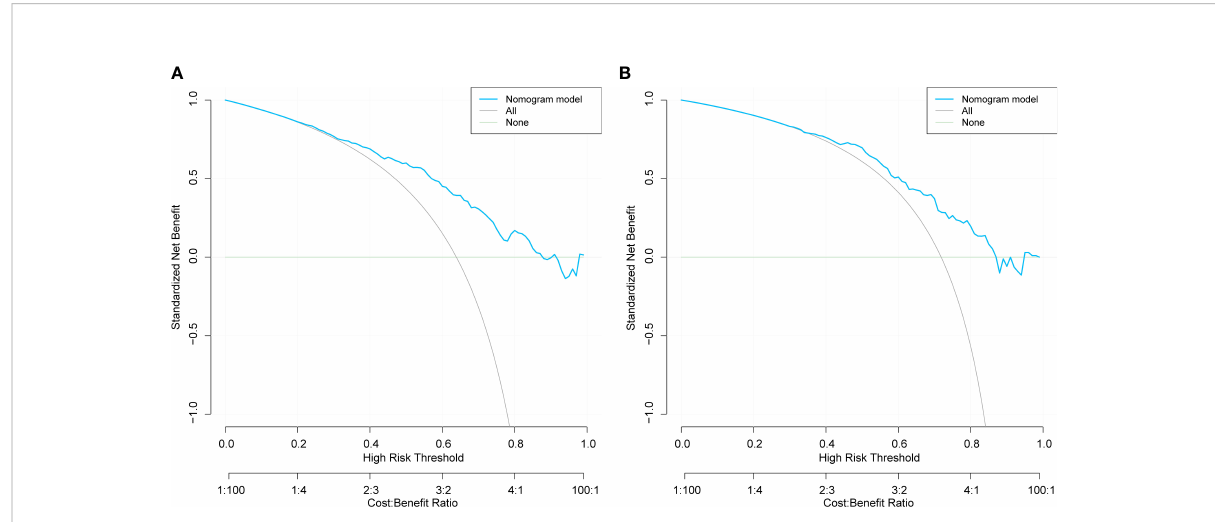
FIGURE 5 Decision curve analysis of training set (A) and validation set (B) for the risk of peripheral artery disease in patients with type 2 diabetes